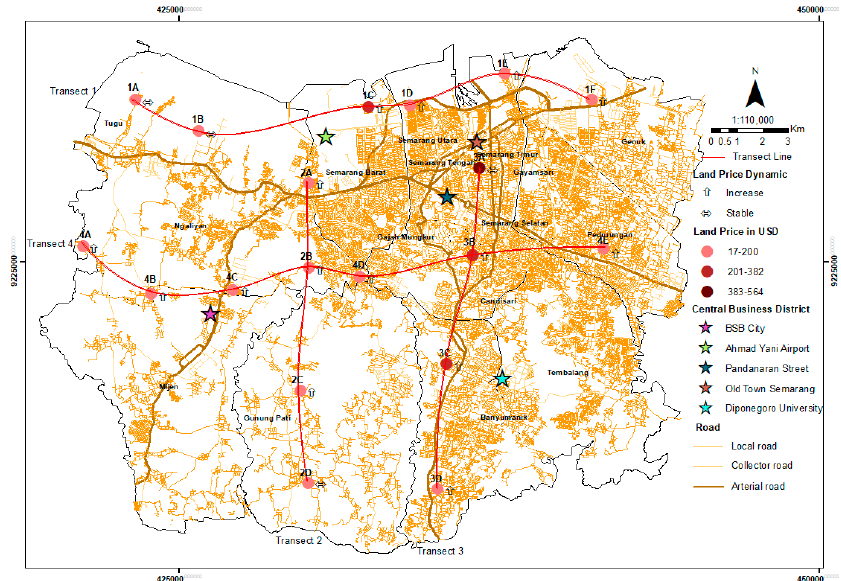
Figure 4. The distribution of land values and roads in Semarang City.